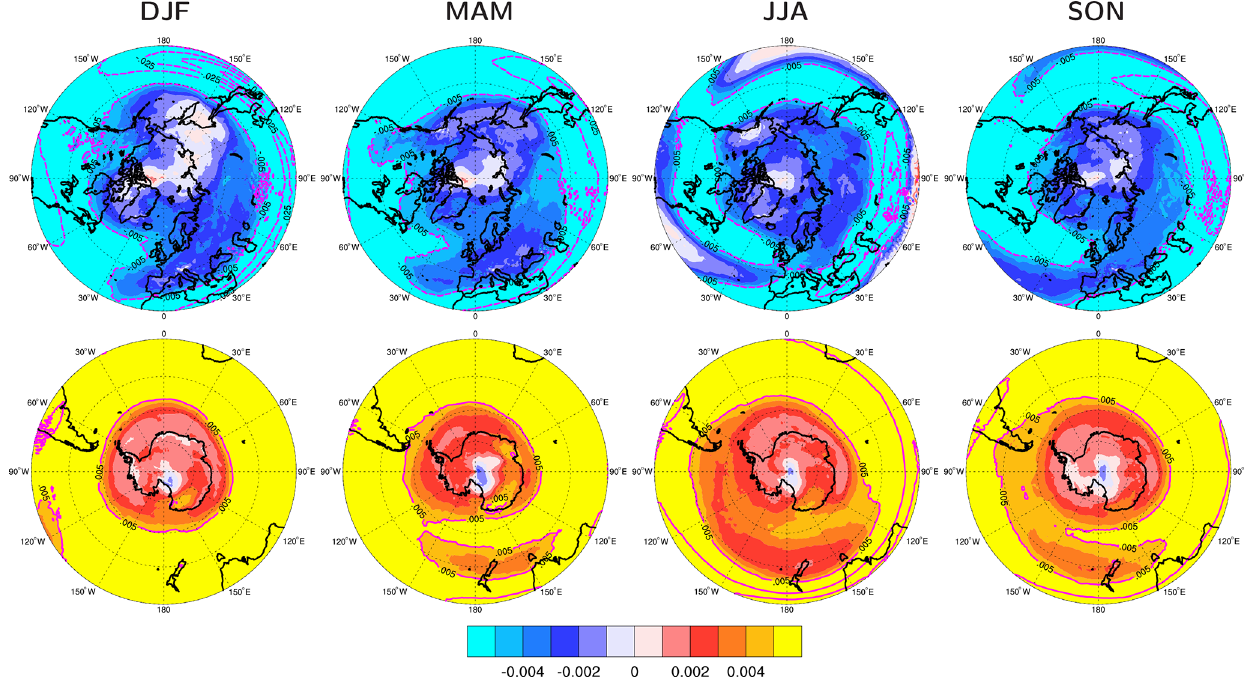
Figure 4. Seasonal climatologies of the meridional gradient of potential temperature θ on the 2PVU surface from the ERA-Interim reanalysis. Contour lines are drawn every 0.005Kkm − 1 , with negative contours dashed and shading used for smaller